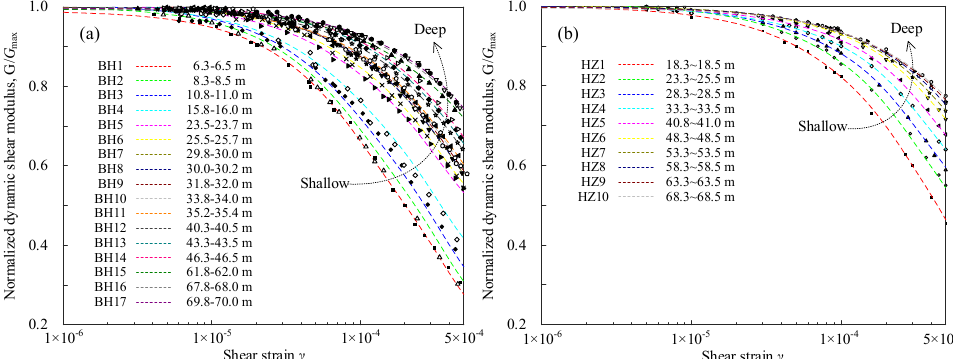
Figure 10. Comparison of measured values and predicted G / G max – γ curves for marine clays from ( a ) Bohai Bay; ( b ) Hangzhou Bay.